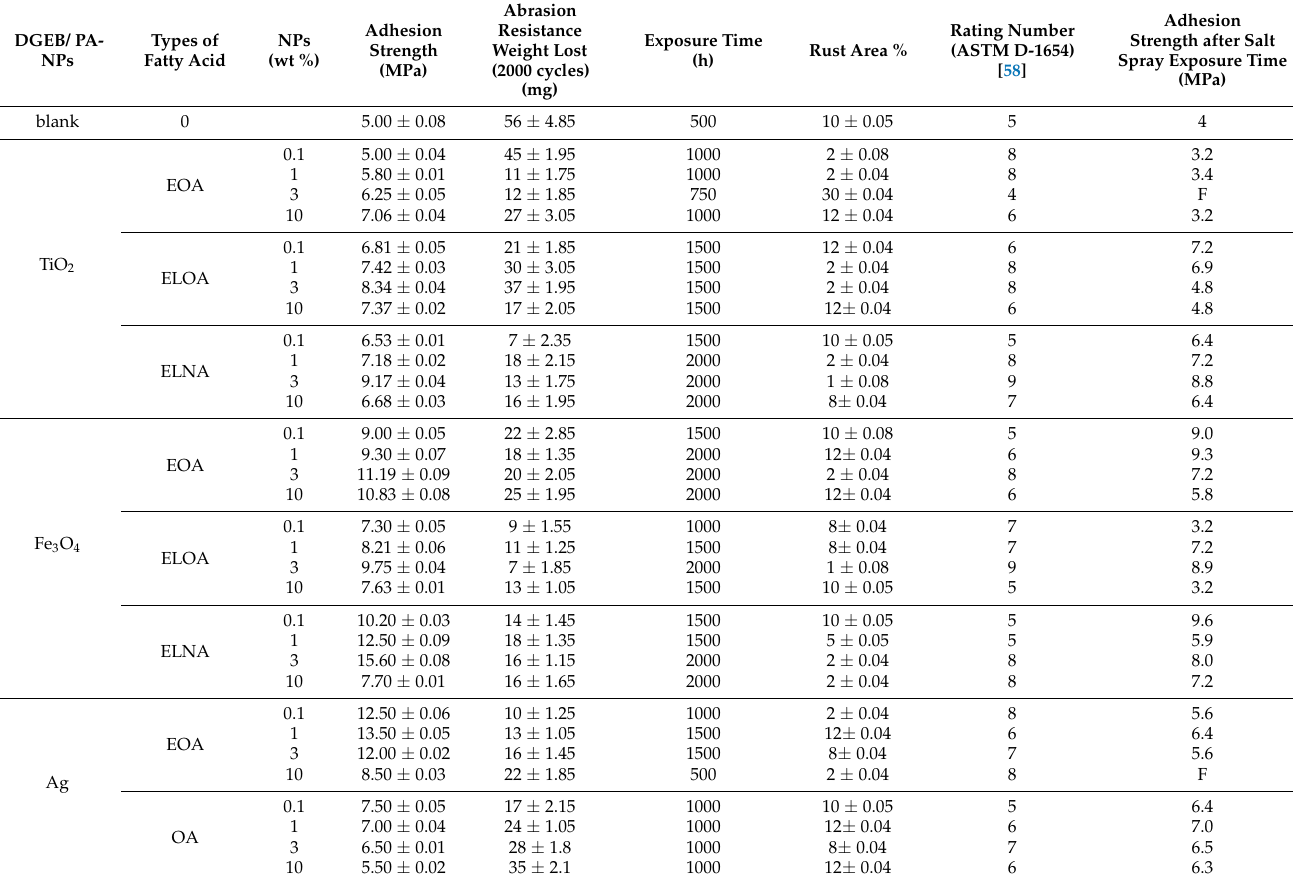
Table 3. Mechanical and salt spray resistance of DGEB/PA nanocomposites coating films at different exposure times.